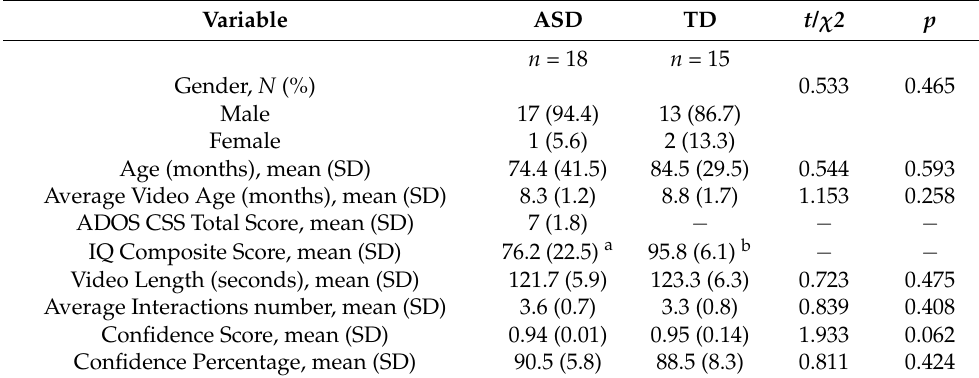
Table 1. Population characteristics of TD and ASD